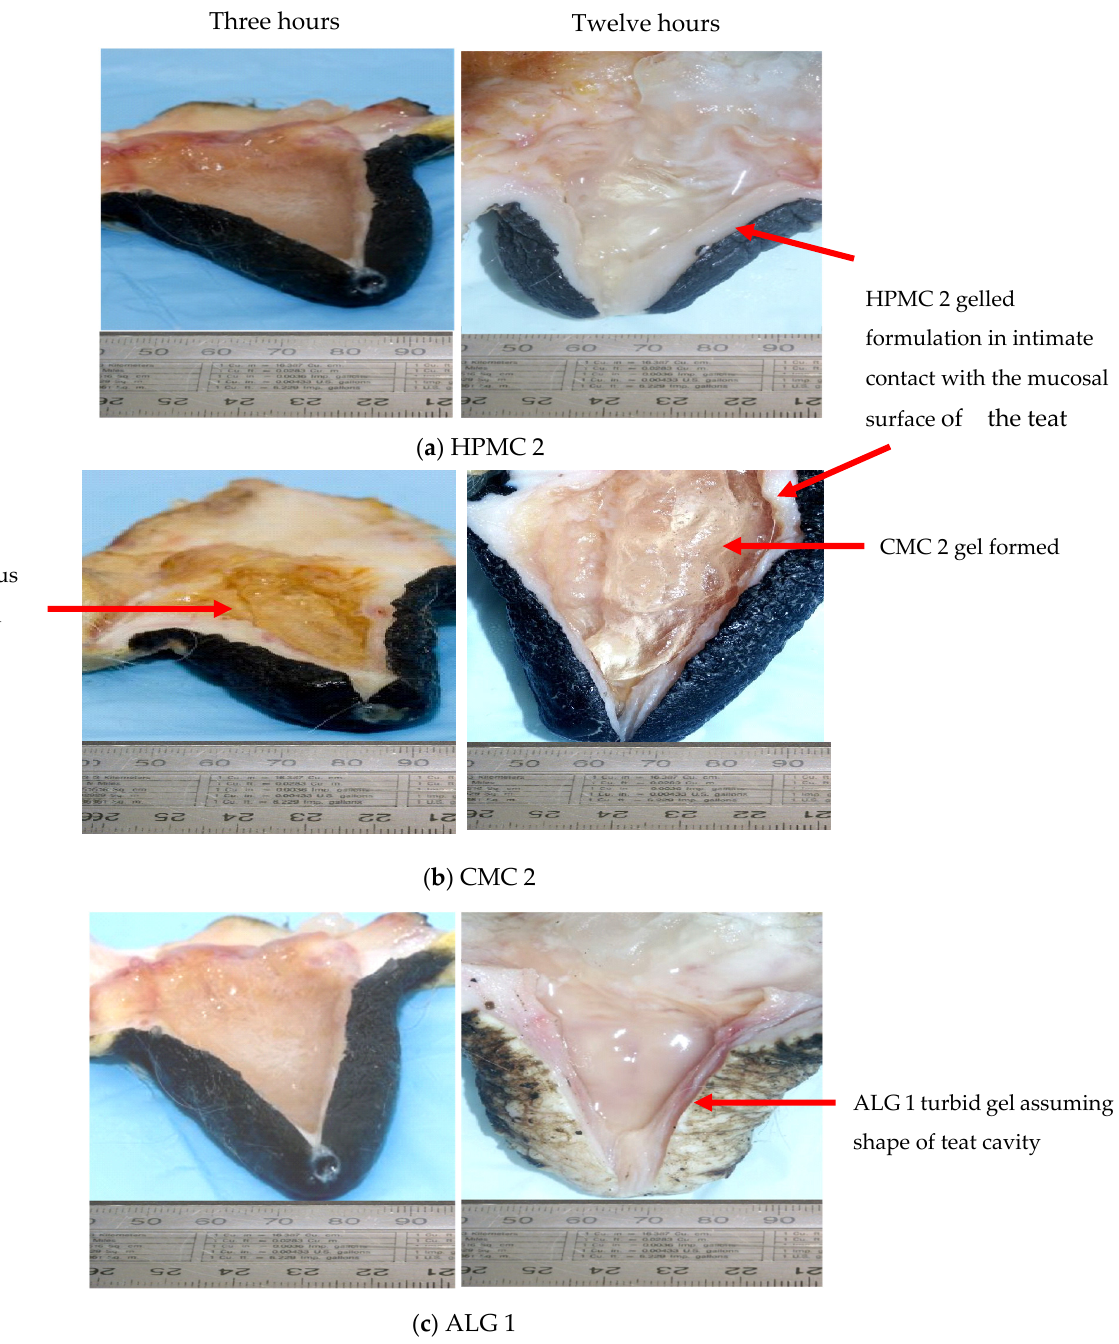
Figure 9. Representative photographs of the internal teat demonstrating in situ formed gels of ( a ) HPMC 2 ( b ) CMC 2 ( c ) ALG 1 after exposure to the infused formulations for 3 and 12 h. (HPMC1 = HPMC 10%, G 49.5%, E 22.5%, W 18%; HPMC2 = HPMC 10%, G 9%, PG 72%, W 9%; CMC 1 = CMC 10%, G 18%, E 45%, W 27%; CMC 2 = CMC 10%, G 27%, E 45%, W 18%; ALG 1 = ALG 10%, G 31.5%, PG 31.5%, W 27%; ALG 2 = ALG 10%, G 18%, PG 36%, W 36%; W = water as co-solvent) .